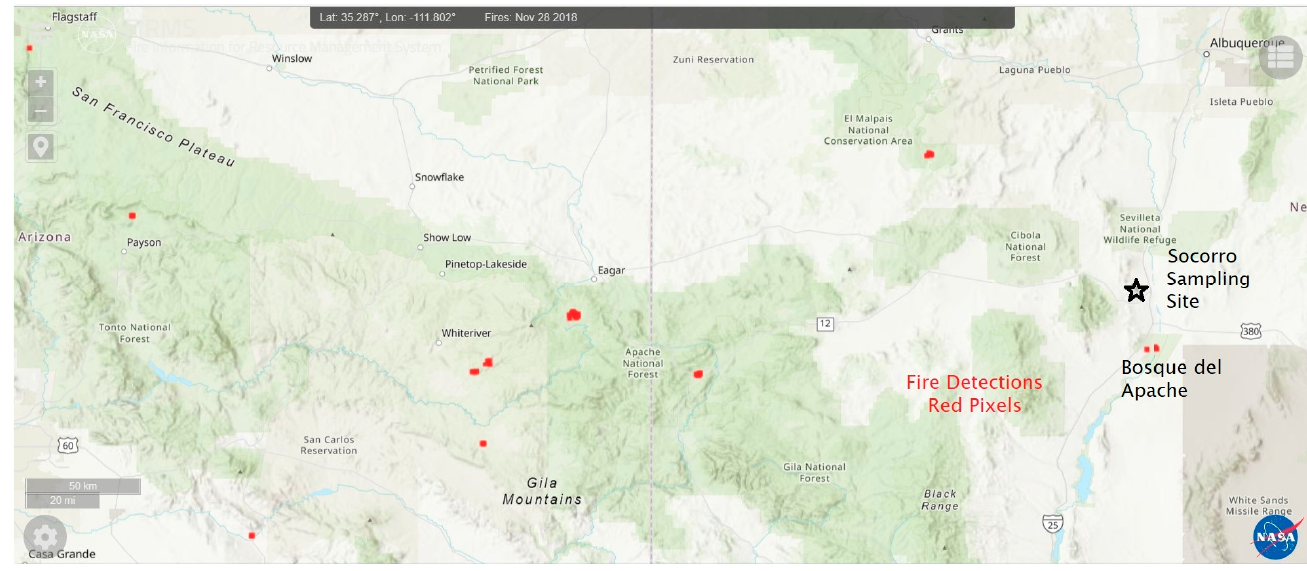
Figure 8. NASA FIRMS satellite data on regional fire detection hotspots in the upwind direction from Socorro, NM (circled receptor site) on 28 November 2018. The prescribed fire satellite detected burn areas (red areas) are shown in the circled area to the south of the Socorro site.